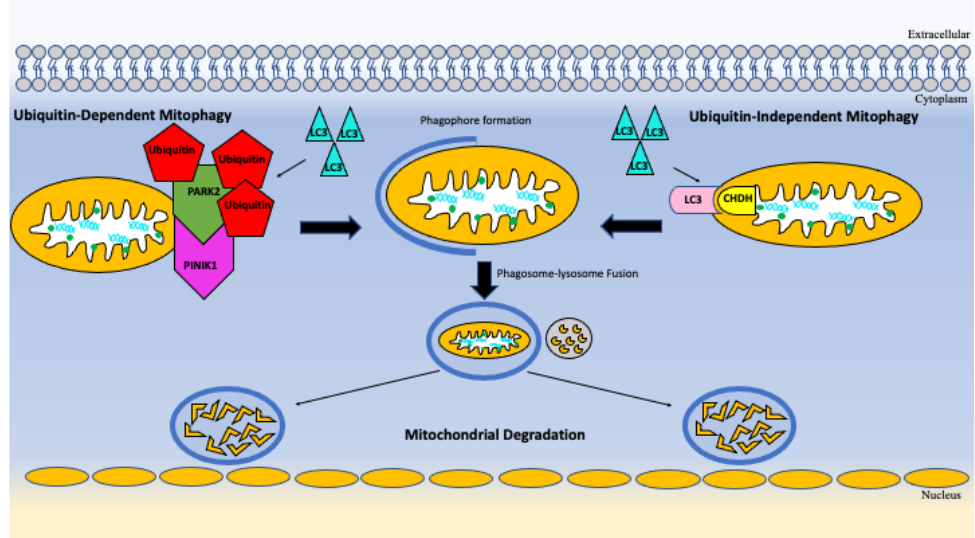
Figure 3. Mitophagy pathways demonstrating mitochondrial turnover.